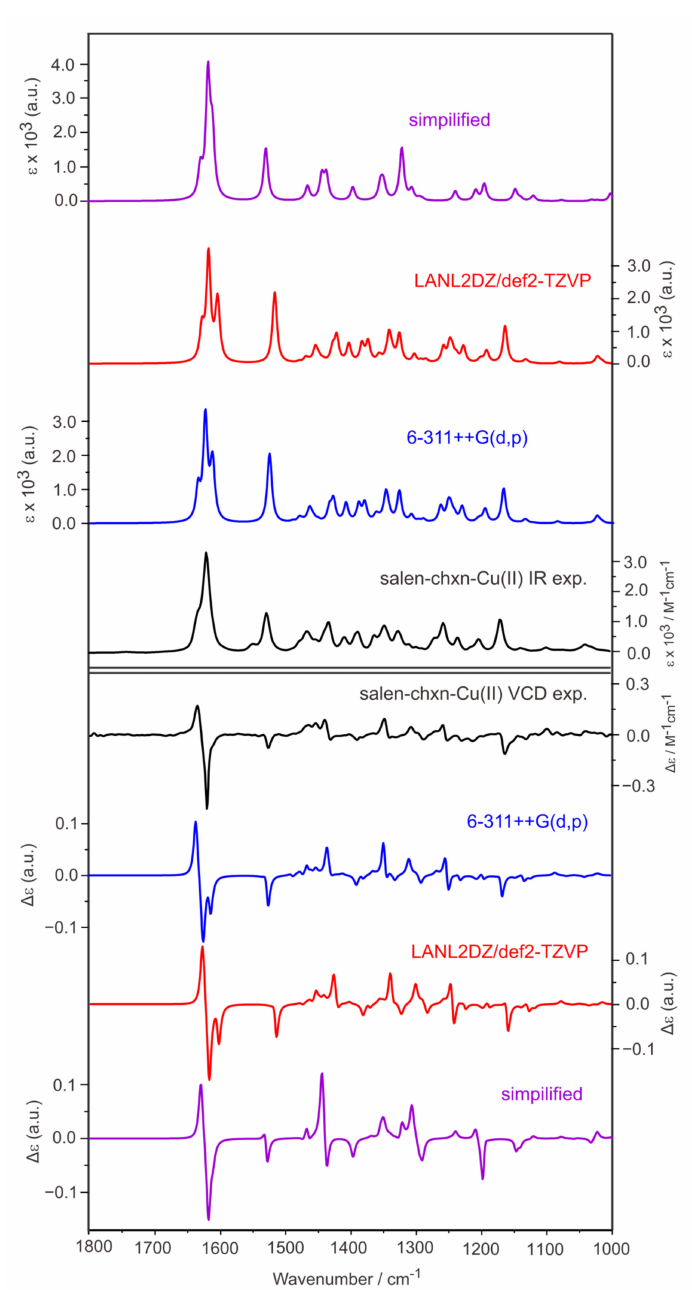
Figure 8. Comparison of the experimental IR ( top ) and VCD ( bottom ) spectra of salen-chxn-Cu(II) with the corresponding calculated spectra in CDCl 3 solution. The levels of theory used are B3LYP- D3BJ/6-311++G(d,p) and B3LYP-D3BJ/def2-TZVP+LANL2DZ(for Cu) with the PCM of chloroform. The simplified calculations were done by replacing tBu with an H